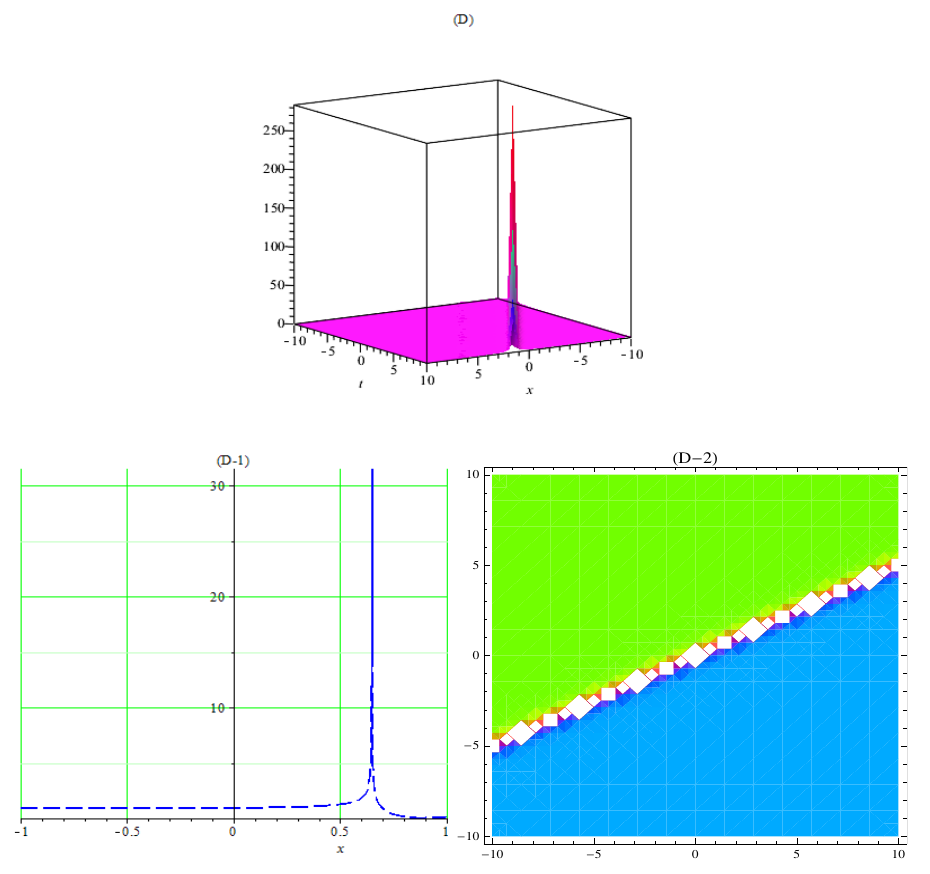
Figure 4. ( D ) 3D graph of singular soliton of (40) using l = 2.2, m = 0.4, µ = 0.6, A = 2.7, ζ = 0.5, V = 0.3. ( D-1 ) 2D plot and ( D-2 ) contour plot of